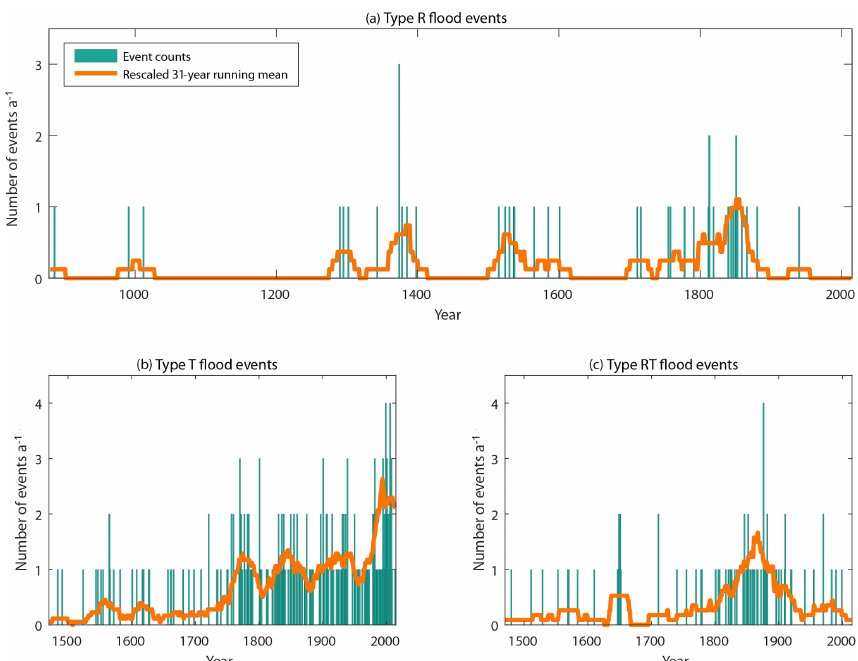
Figure 10. Chronologies according to hydrological configuration. Type R events correspond to flood events that have affected the Rhine River alone. Type T events have affected one or several Alsatian tributaries of the Rhine River but not the Rhine River. Type RT events have affected both the Rhine River and at least one of its Alsatian tributaries.